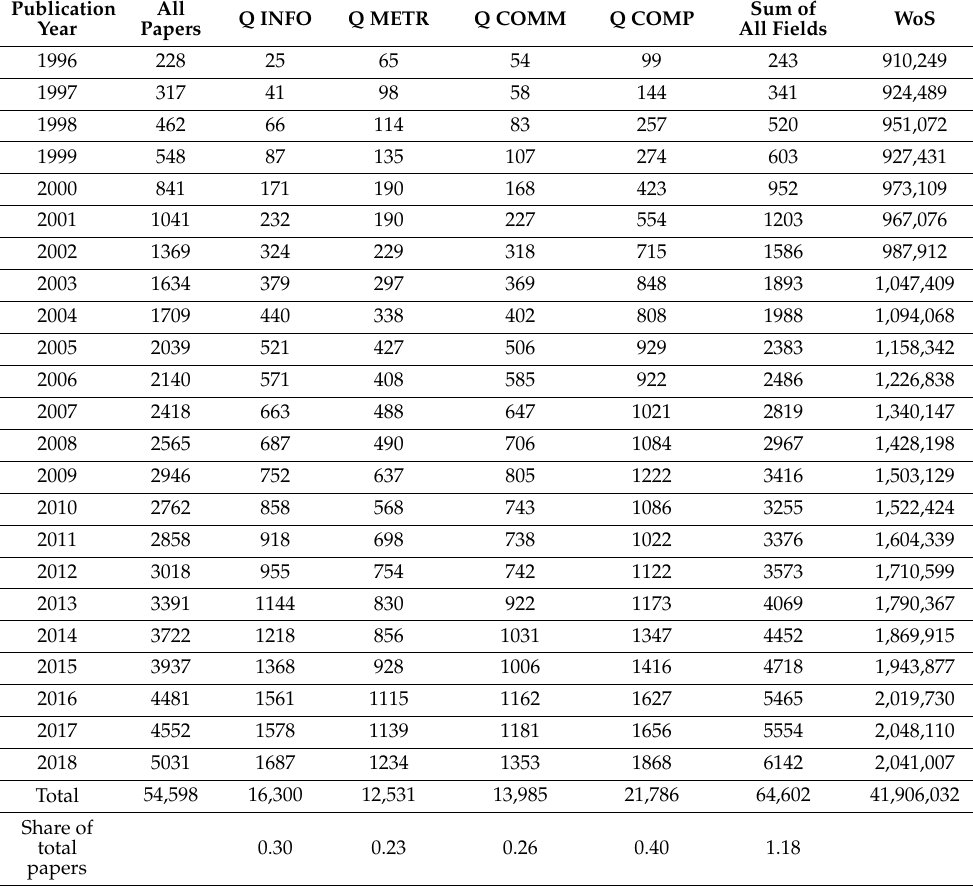
Table A2. Description of the common thesaurus file (https://s.gwdg.de/4DDxsp (accessed on